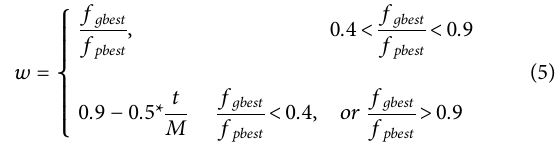
a Represent the GPS, data. b Represent the InSAR,